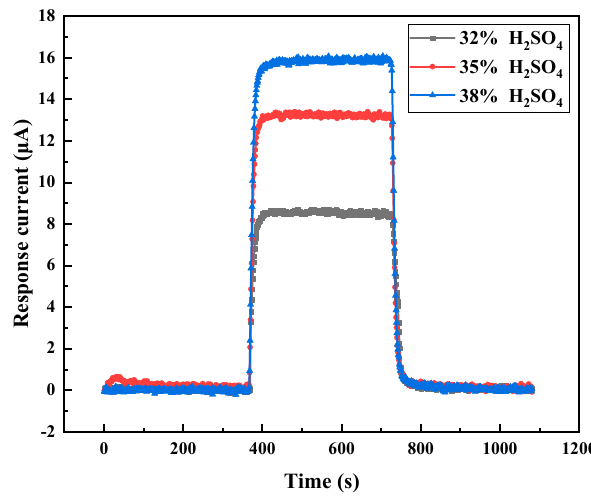
Figure 8. Effect of H 2 SO 4 concentration on the response of the gel electrolyte electrochemical CO gas sensor. Test conditions: 25 °C, 50%RH, 200 ppm CO, and 1000 sccm CO.